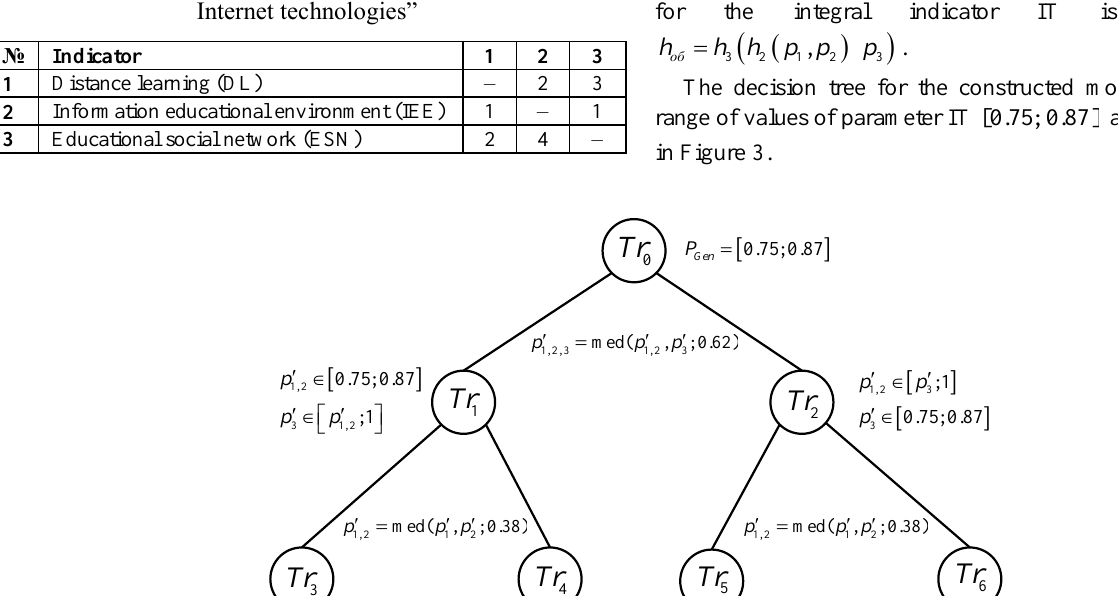
Table 12 – Compatibility matrix of the second-level evaluation indicators for the integral indicator “The use of